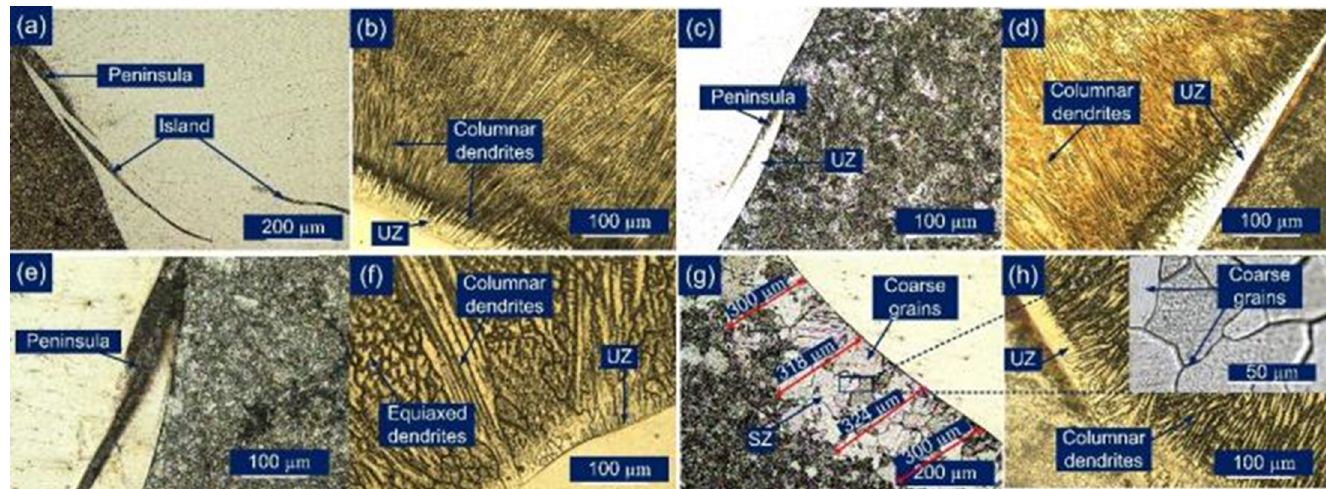
Figure 4. Optical image of the interface region in the AW joint: ( a , b ) interface of P91 steel and ERNiCrMo-3 weld metal; ( c , d ) interface of P22 steel and ERNiCrMo-3 weld metal; after PWHT: ( e , f ) interface of P91steel and ERNiCrMo-3 weld metal; ( g , h ) interface of P22 steel and ERNiCrMo-3 weld metal.